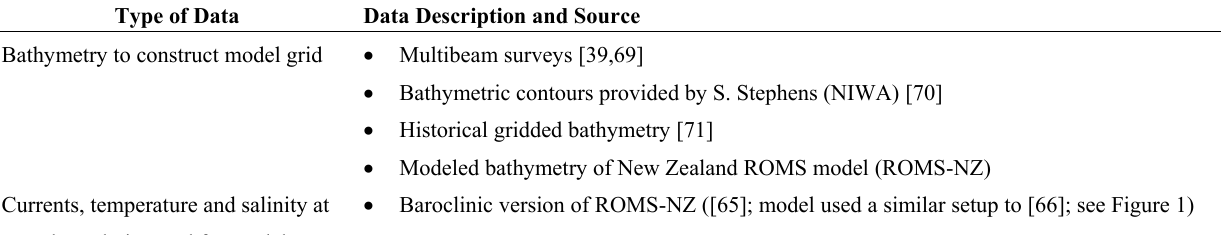
Table 3. Datasets used for model initialization and